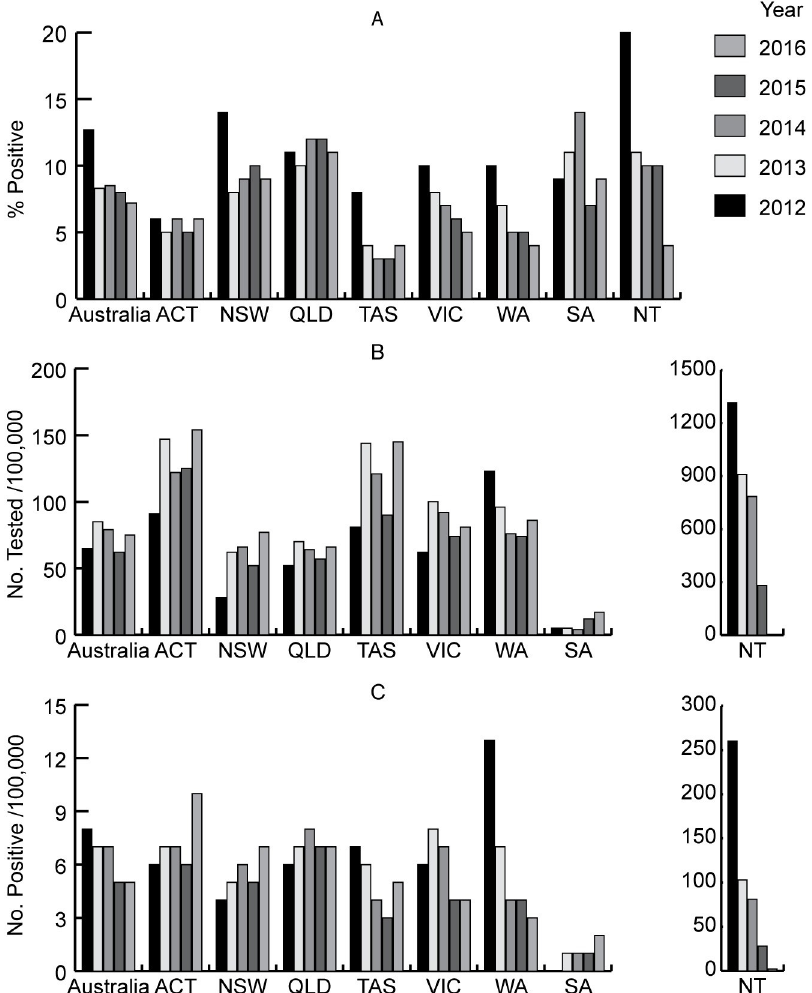
Fig 4. Strongyloides serology: number of people tested and positive in each year, 2012 − 2016 1 , (excluding the data from the SA laboratory that provided positive results only 2 ): Australia and states and territories. A. Percent positive of those tested. B. Number of people tested per 100,000 of population. C. Number of people positive per 100,000 of population. 1 Number of people positive per 100,000 of population. 2 The values for SA in B and C are considerably underestimated because of the exclusion of data from the laboratory in SA. ACT = Australian Capital Territory; NSW = New South Wales; NT = Northern Territory; QLD = Queensland; SA = South Australia; TAS = Tasmania; VIC = Victoria; WA = Western